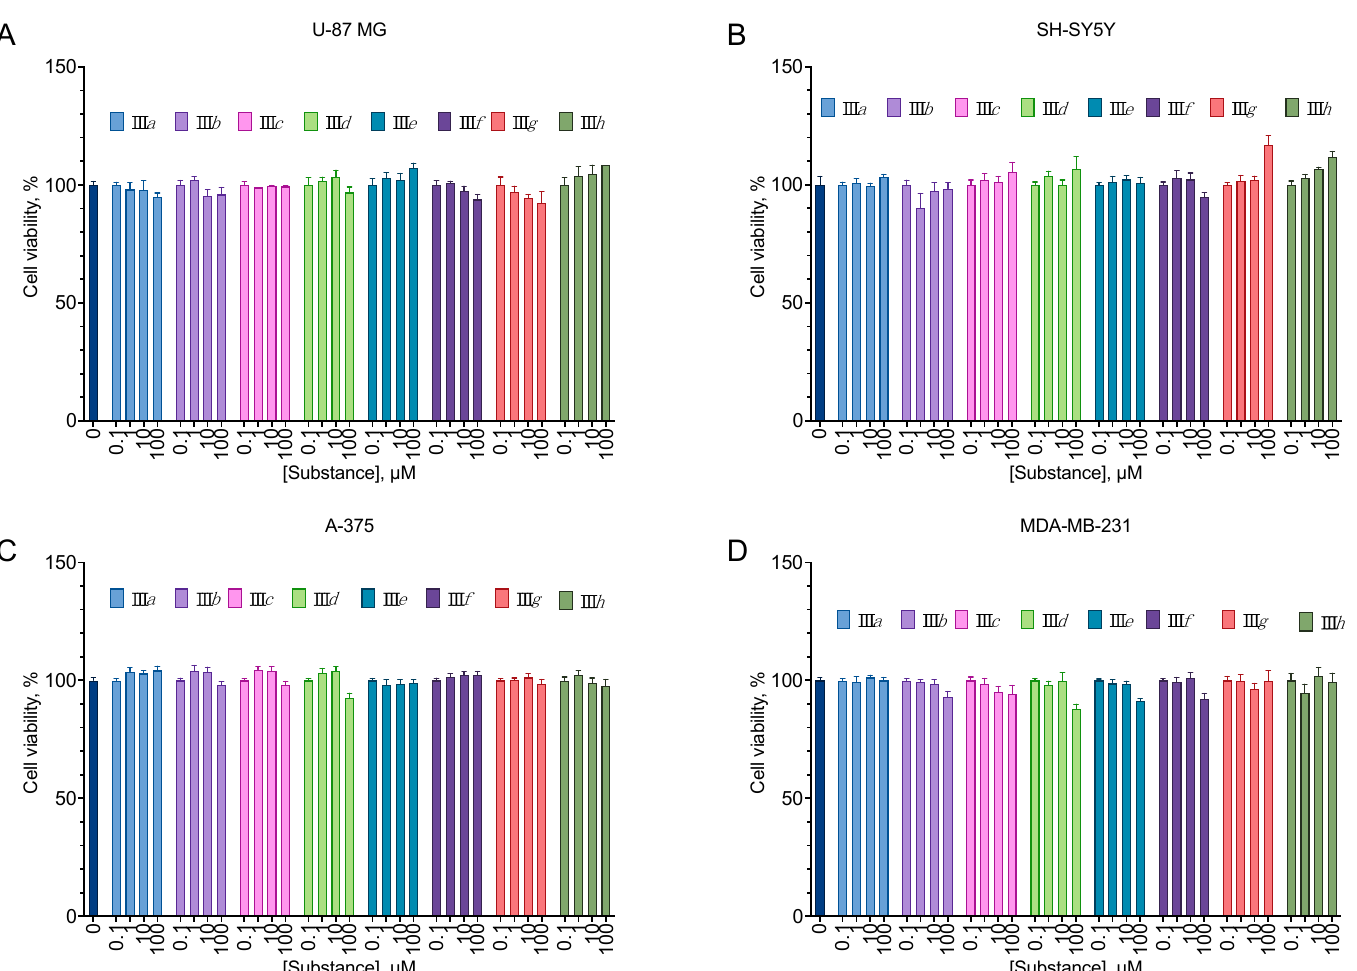
Figure 2. Anti-proliferative activity of the compounds III a – h on the U-87 MG glioblastoma ( A ), SH-SY5Y neuroblastoma ( B ), A-375 melanoma ( C ), and MDA-MB-231 carcinoma ( D ) cell lines. Negative control cells (100% viability) were treated with 0.5% DMSO. Positive control cells (100% cell death) were treated with 3.6 µ L of 50% Triton X-100 in ethanol per 200 µ L of the cell culture medium. 24 h incubation. MTT test data. Mean ± standard error ( n = 5 experiments).